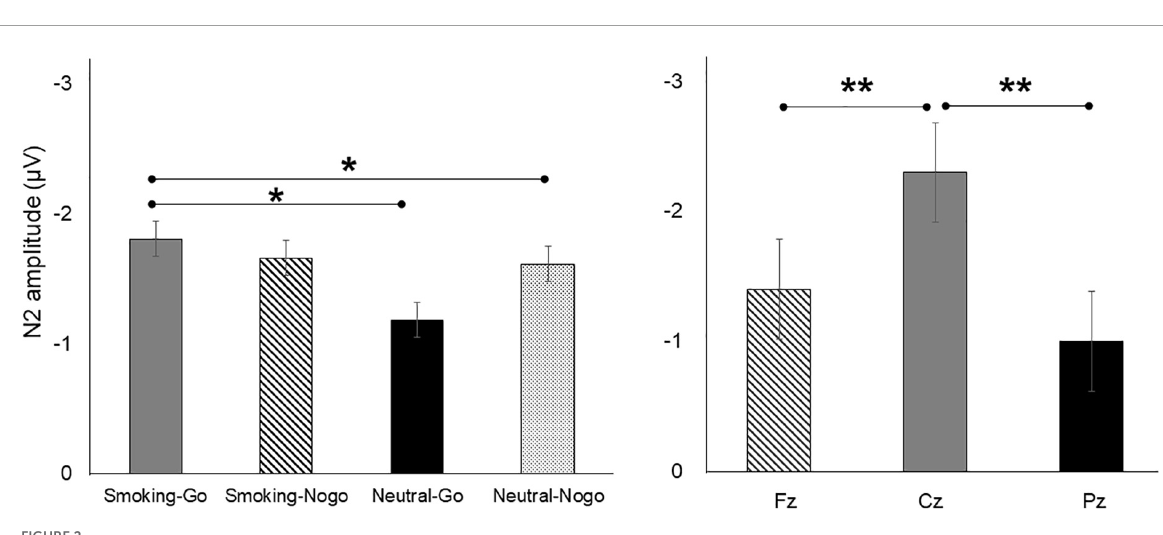
sites [ F ( 6 , 1044 ) = 4.100, p = 0.000, η p 2 = 0.023]. Post